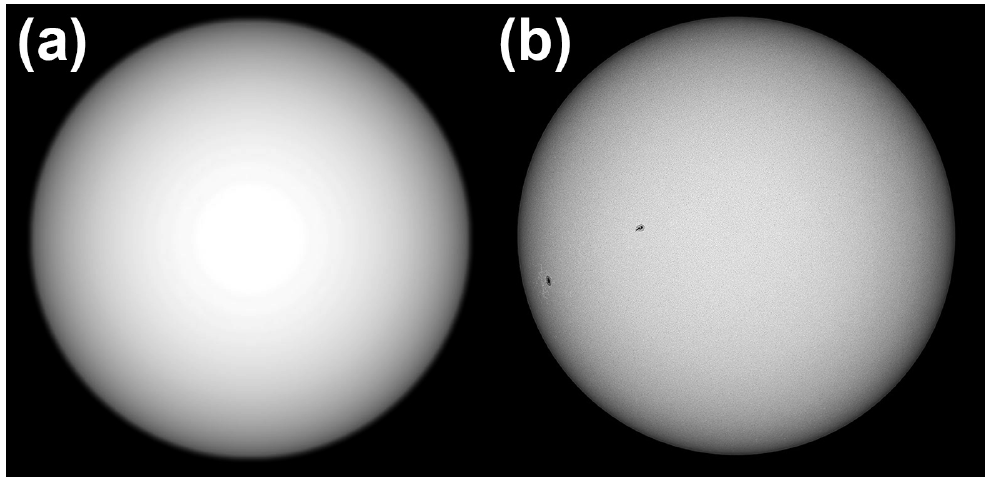
Figure 4. ( a ) Calculated solar disk intensity distribution. ( b ) Real image of the solar disk showing limb darkening (© Matúš